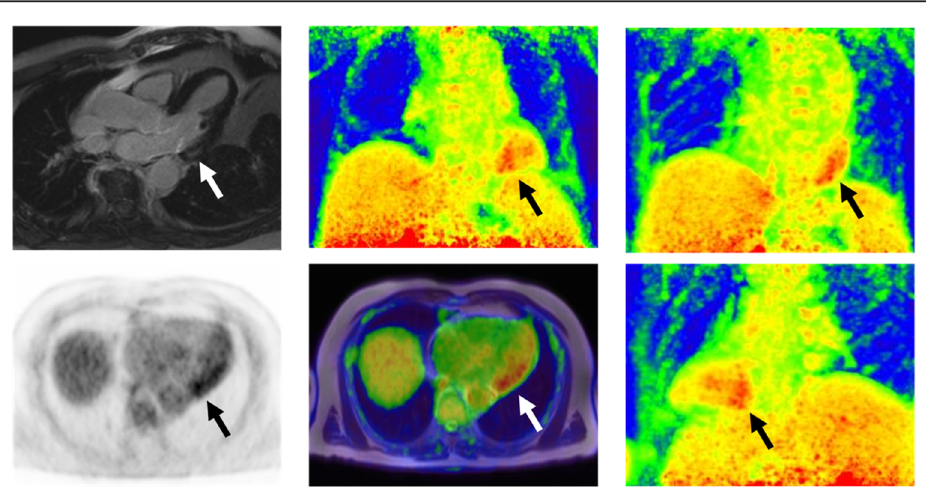
Figure 1. Example of a metastatic malignant melanoma patient under nivolumab treatment in whom checkpoint inhibitor-related myocarditis was verified by 18 F-FDG PET/MR in our institution. Clockwise from upper-left: Late-phase MR, maximum-intensity-projection PET images from three different angles (anterior, posterior, left-posterior view), axial fusion PET/MR, axial PET. Hybrid imaging showed a hypertrophied normal-sized left ventricle with normal left ventricular ejection fraction and with circumscribed left-ventricular midmyocardial late gadolinium enhancement (infero-latero-basally, white arrow in upper-left image), mild edema, and increased 18 F-FDG accumulation (black/white arrows in PET image) which was indicative of active myocarditis.